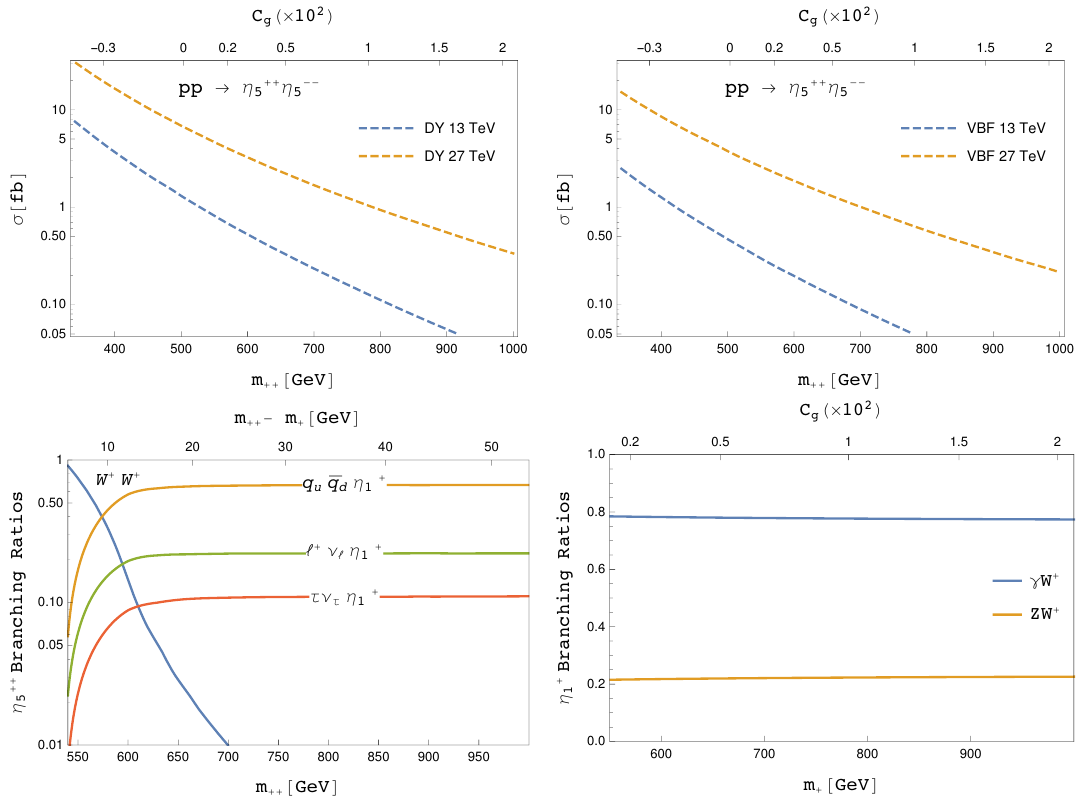
Figure 12 . Upper plots : cross-section for Drell-Yann (left) and VBF (right) pair production of the doubly-charged pNGB (cid:17) ++ , for 13 TeV and 27 TeV (HE-LHC). Lower plots : branching ratios for the 5 (cid:17) ++